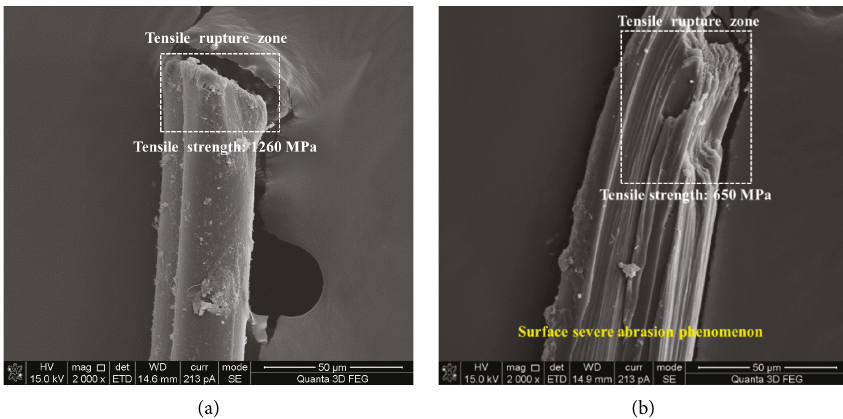
Figure 16: SEM images of fiber rupture zone. (a) Direct tensile rupture manner. (b) Tensile rupture from matrix